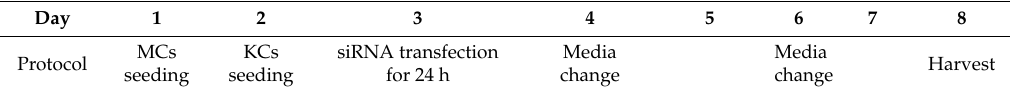
Table 3. The protocol for knockdown of guanine